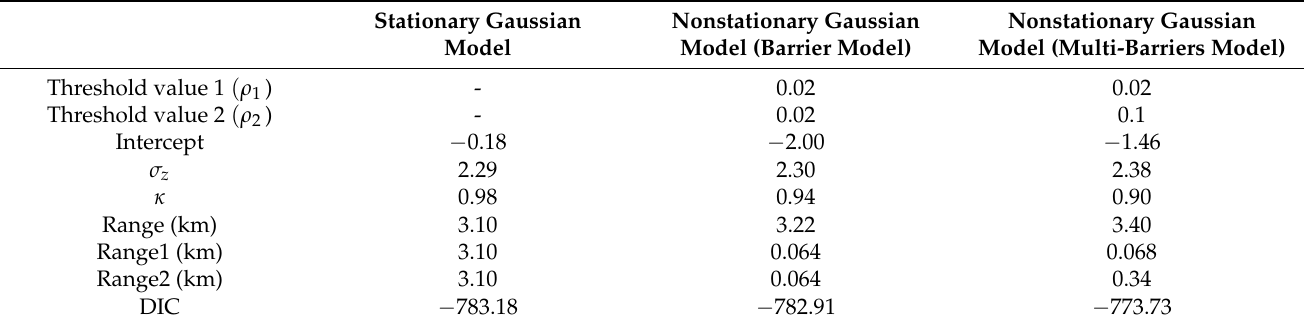
The parameters in Table 2 convey the same meaning as those in Table 1. Comparing the posterior distribution of the parameters for the three considered models in Figure 9 and the posterior means of parameters in Table 2, it is seen that the parameters and DIC values of these models are close. However, the Intercept of the stationary Gaussian model